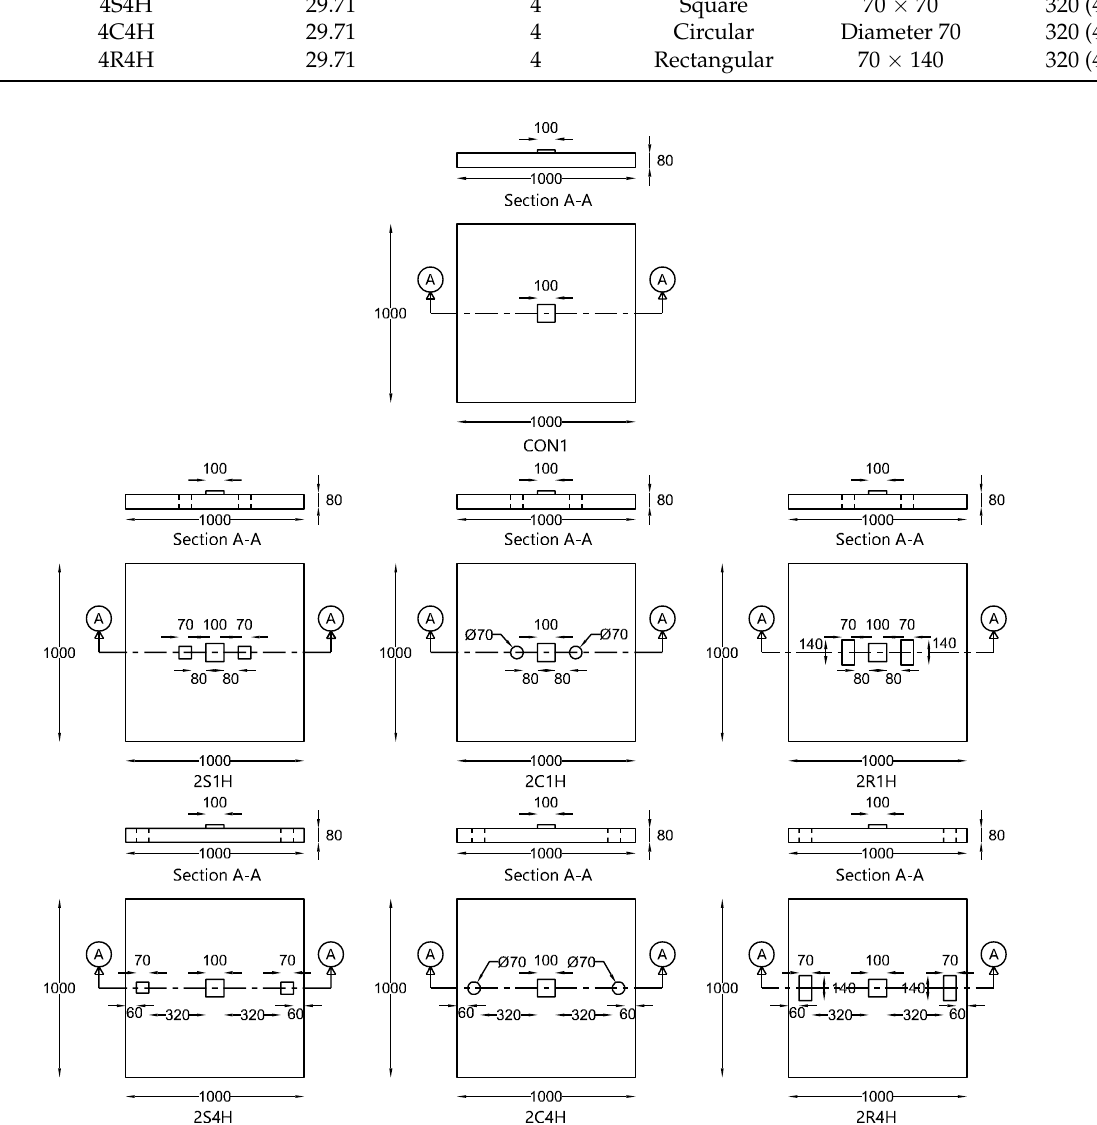
Figure 1. Layout of specimens with 2 openings (units: mm).